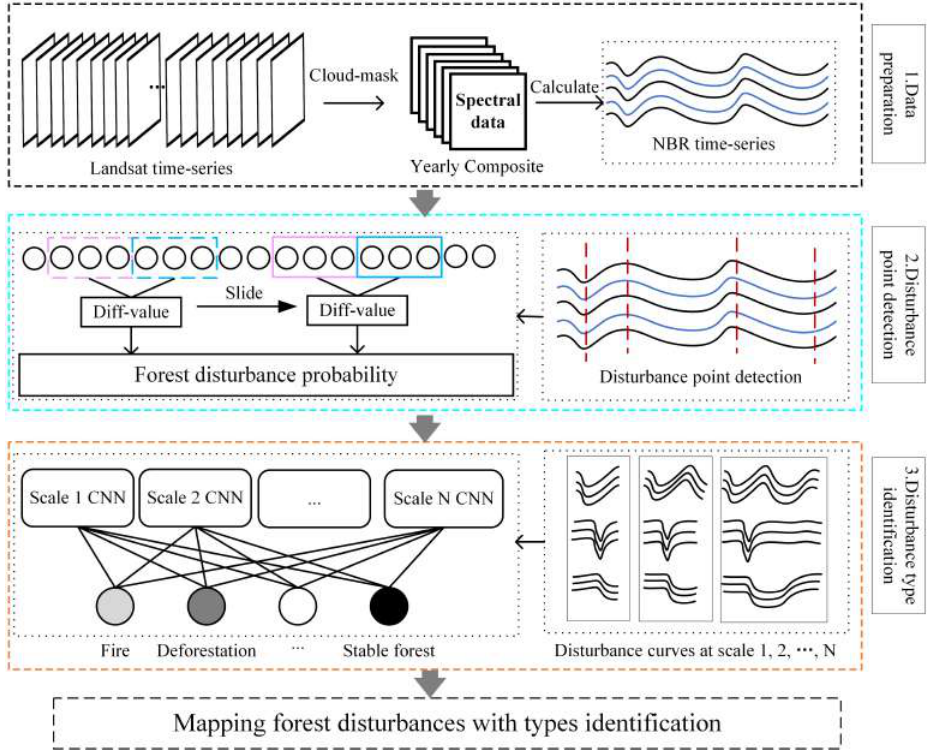
Figure 4. Flowchart of proposed integrated MT-CNN. ( 1 ) yearly composite data are prepared for analysis; ( 2 ) disturbance point is detected with sliding window technique; ( 3 ) disturbance type recognition with multitemporal time-series